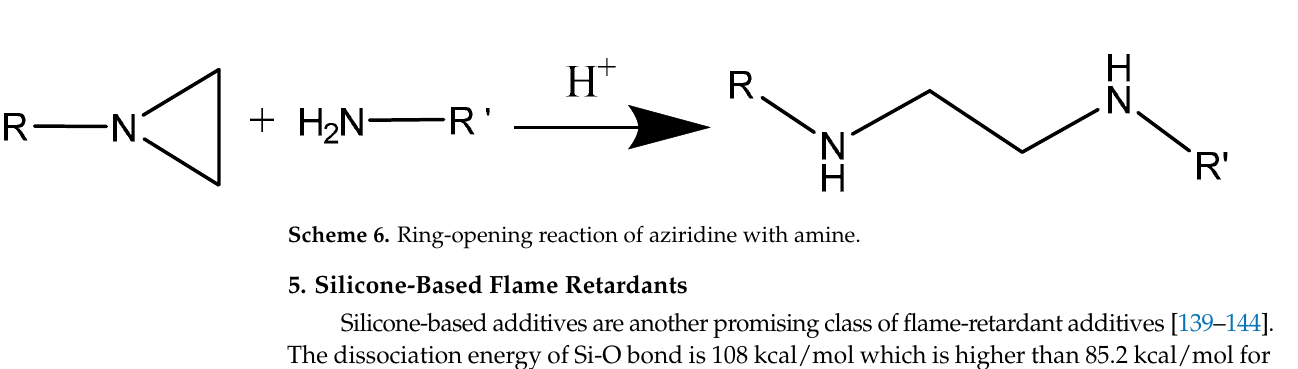
Scheme 5. Structure of aziridinyl phosphazene.